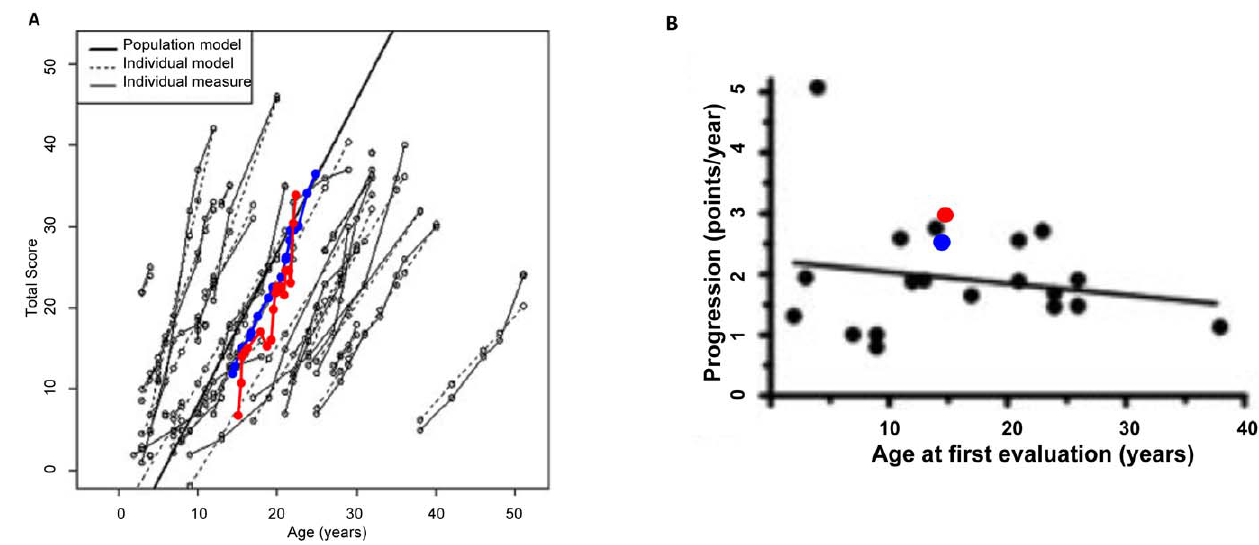
Figure 4. Assessment of two new NP-C patient medical records donated directly to the study. A. Disease severity curves of medical record donated in Spring 2010 (red) and Spring 2011 (blue). The Spring 2010 case was assessed by four students. The Spring 2011 case was assessed by 30 students . The data were overlaid on disease severity curves obtained by Yanjanin et al., 2010. B. The progression slopes of two curves shown in panel A were determined by linear regression and overlaid onto the progression slope created by Yanjanin et al. 2010.